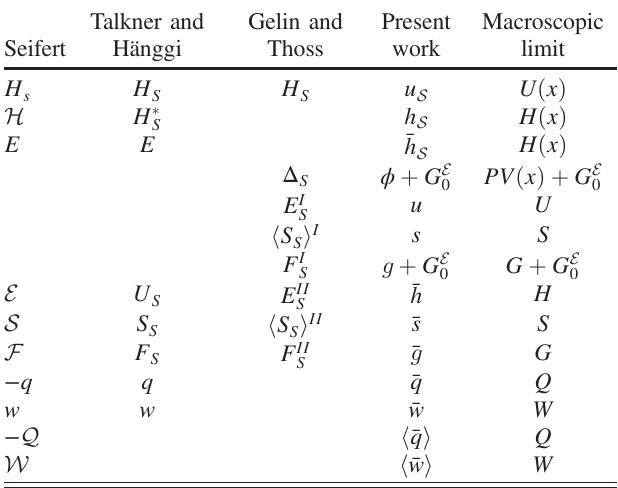
TABLE II. Quantities introduced by Seifert [15], Talkner, and Hänggi [17] and Gelin and Thoss [12] are listed alongside their counterparts in the present paper. The last column shows how these quantities scale up, for a macroscopic system of interest. The superscripts I and II refer to the two approaches in Ref.